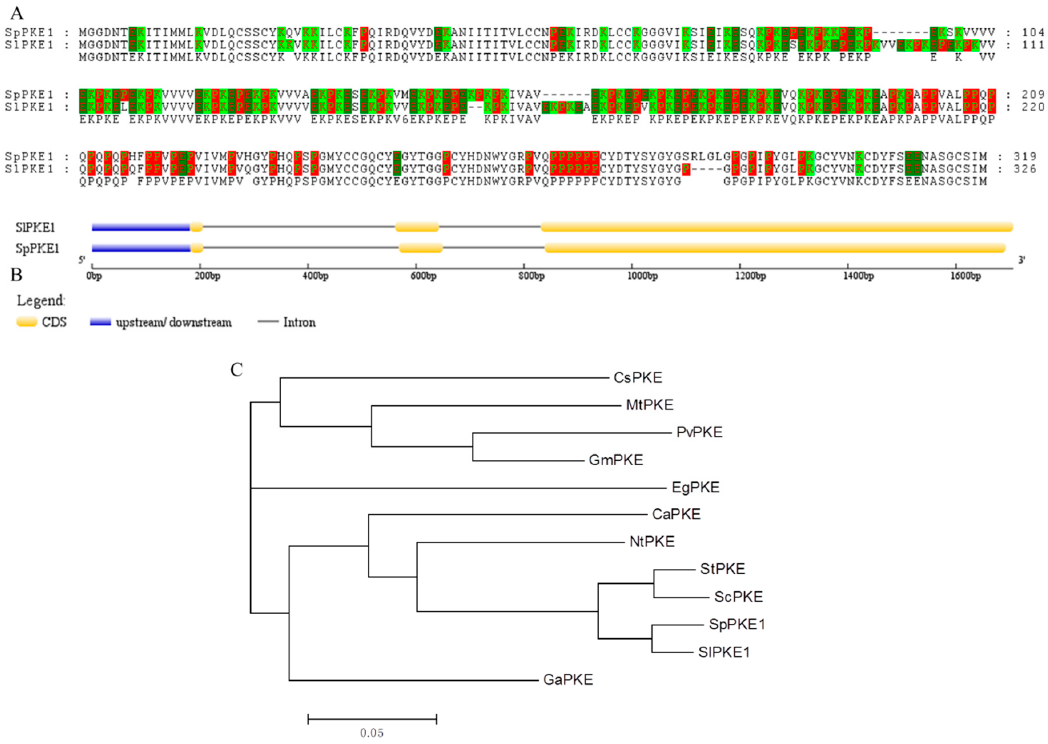
Figure 1. Comparison of amino acid sequence and phylogenetic analyses of PKE1. ( A ) Amino acid alignment of S. lycopersicum cv. M82 (SlPKE1) and S. pennellii LA0716 (SpPKE1). ( B ) Gene structure of the tomato SlPKE1 and SpPKE1 generated from Gene Structure Display Server (GSDS). The yellow block indicates the coding sequence (CDS), the blue block refers to upstream or downstream of the genes, the black line represents the intron. Scale bar indicates the DNA sequence length. ( C ) Neighbor Joining tree for SlPKE1, SpPKE1 and PKE1 from their highest similarity proteins in the EBI (European Bioinformatics Institute) database. The PKE1 from other species are as follows: CsPKE1 ( Citrus sinensis :